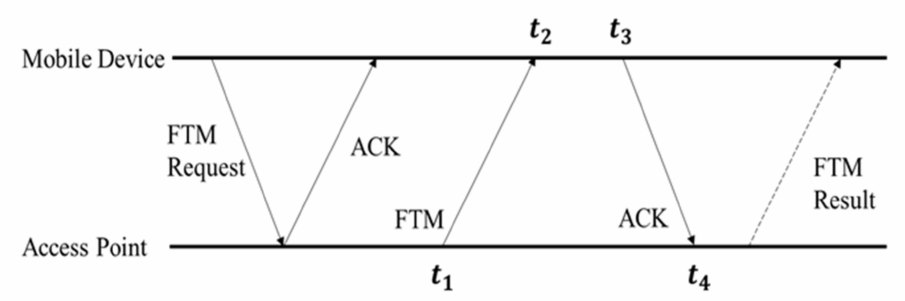
Figure 2. Wi-Fi FTM